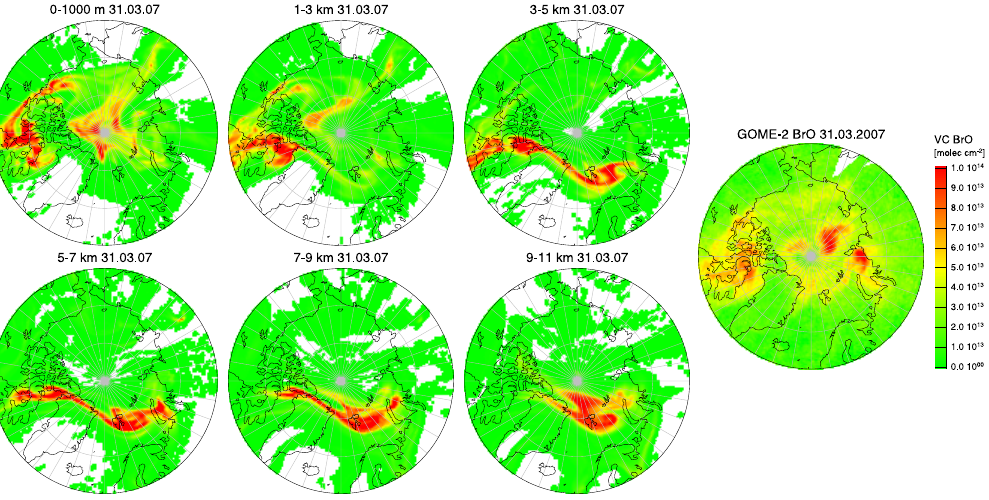
Fig. 5. FLEXPART model results for different initialisation heights on 31 March compared to GOME-2 measurments. Model runs above 3km show transport over Greenland not seen in GOME-2 BrO